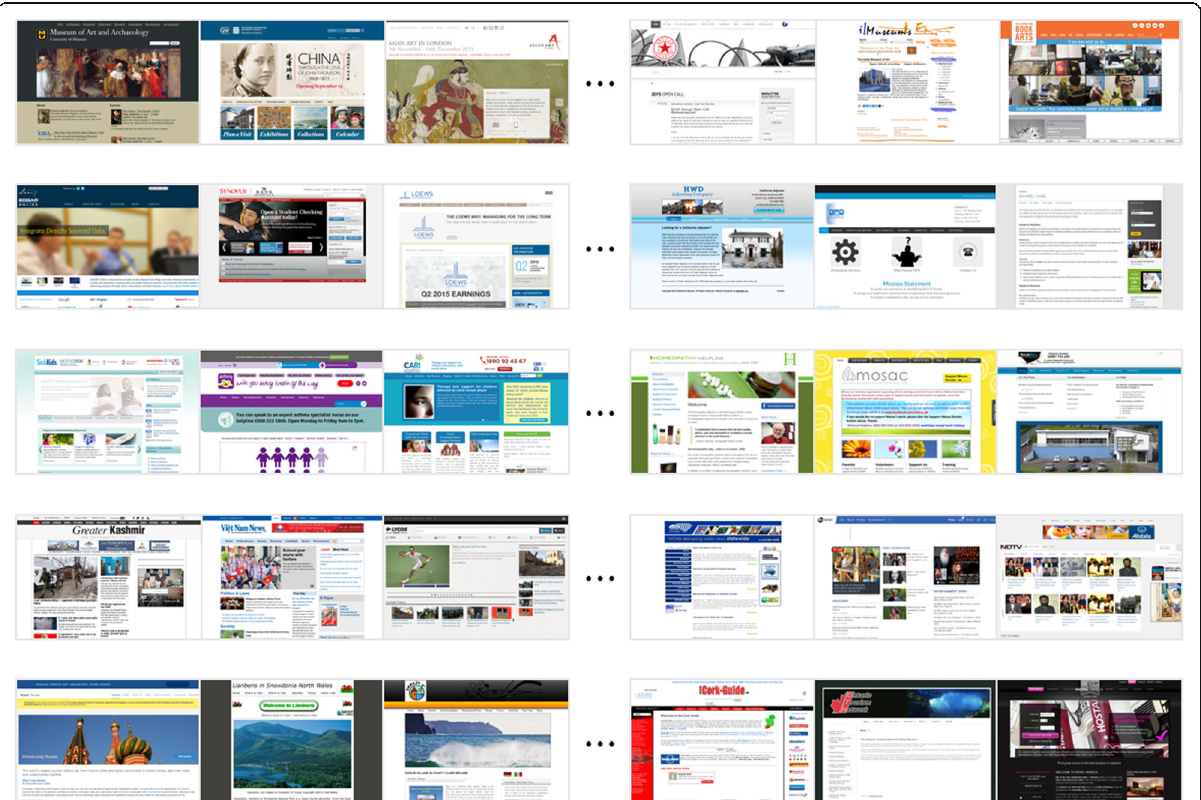
Fig. 4 Example web pages from our corpus. Each row corresponds to a different web page category: (row 1) art place; (row 2) company; (row 3) helpline; (row 4) news; (row 5) tourism. The first three web pages in each row have the highest performance over all subjects, while the last three have the lowest performance, for each